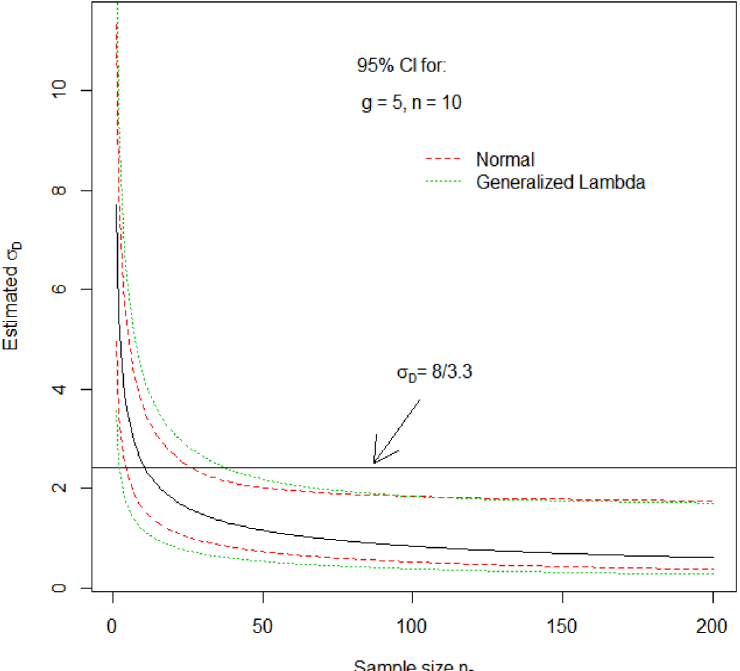
Fig. 7. 95% con fi dence intervals for the estimate of s D versus sample size n 2 for case B, assuming the measurement error distribution is either the normal or the generalized lambda distribution.